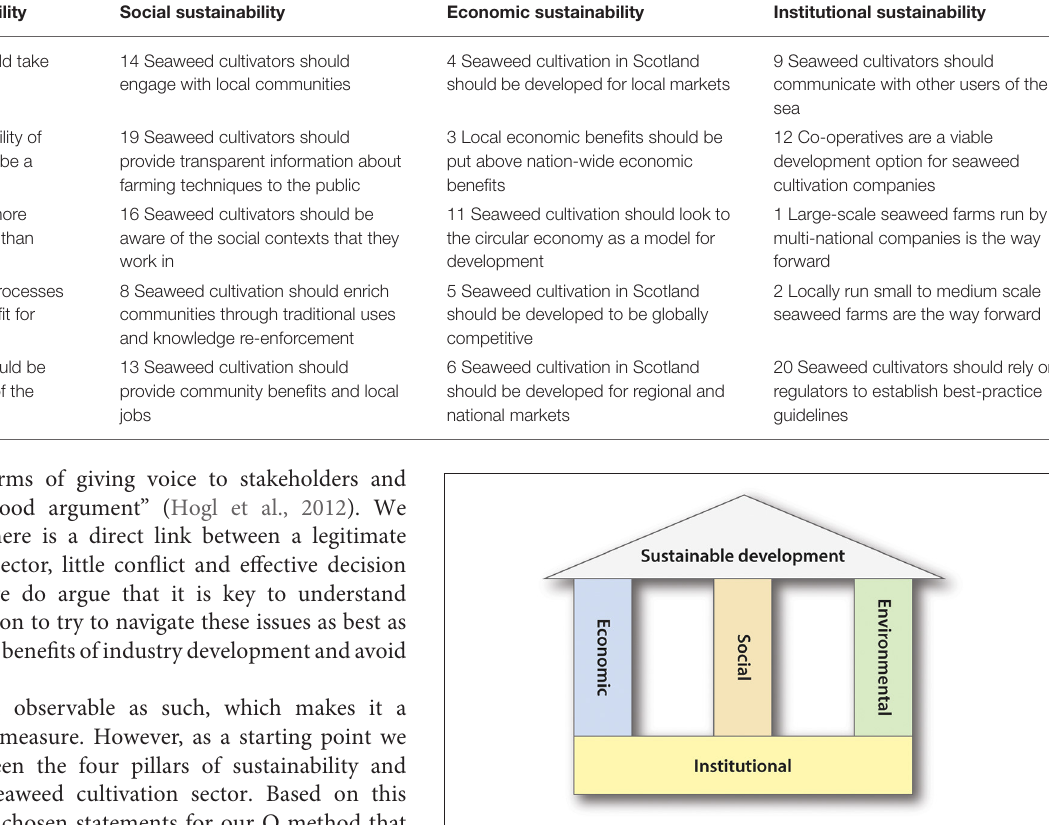
FIGURE 2 | The environmental, economic and social sustainability are the pillars, and the foundation is made of institutional sustainability, which consists of management and governance. After Nofima AS, inspired by University of York and Chemical Industries Association,